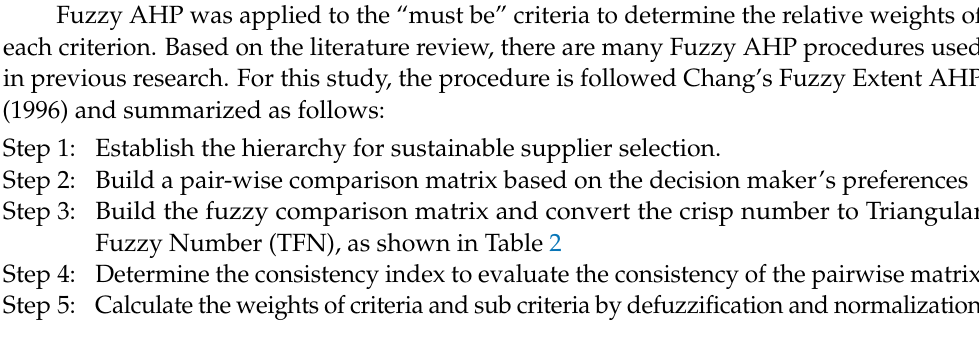
Table 2. Classification of sustainability criteria through the Kano